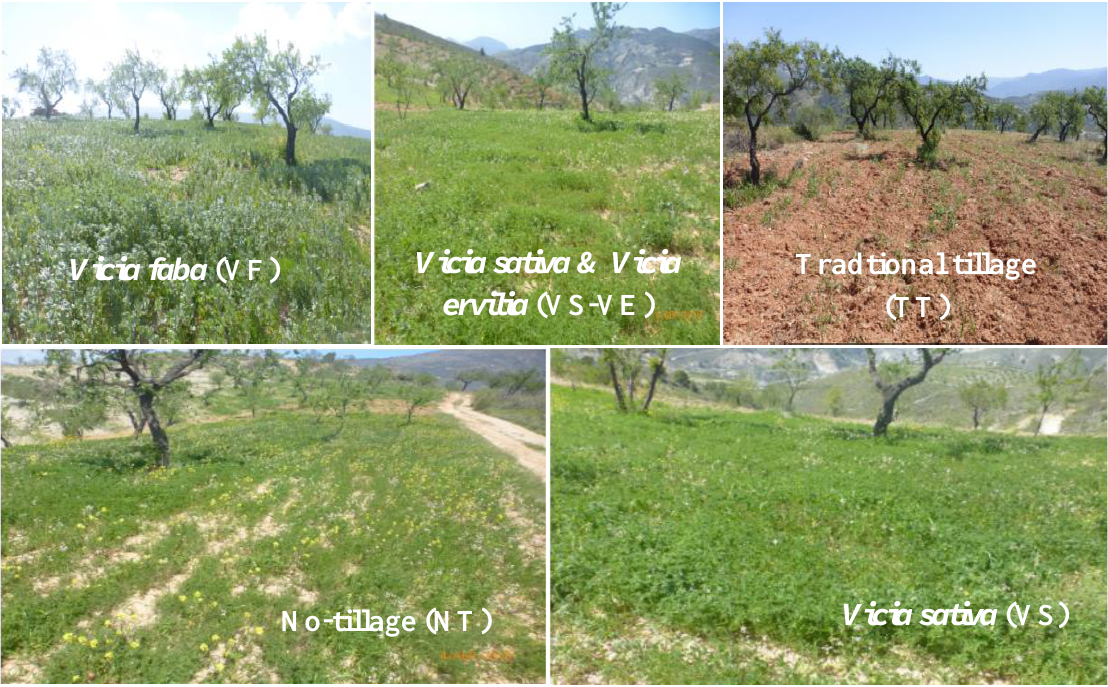
Figure 1. Soil management strategies implemented in the study. Table 2 shows the soil management strategies applied to each agricultural